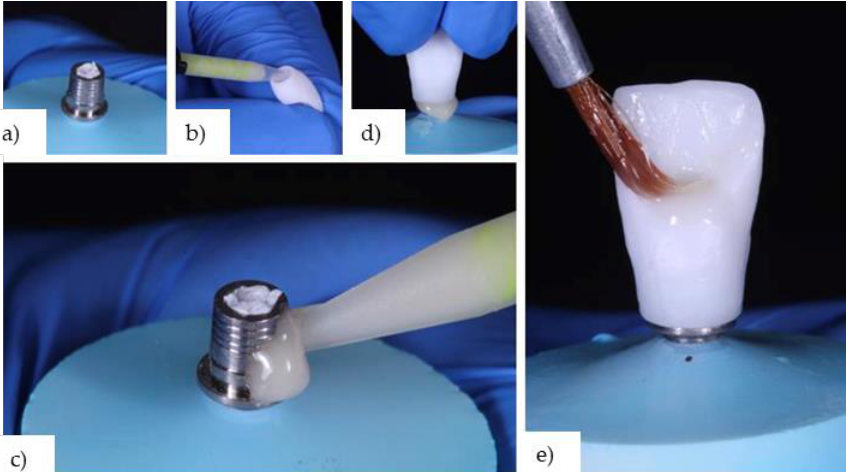
Figure 3. ( a ) Universal link abutment positioned and covered with Teflon tape; ( b ) application of the resin cement in the crown’s intaglio surface; ( c ) application of the cement on the metallic link surface; ( d ) seating the crown on the abutment with leakage of the cementing agent; ( e ) removal of excess cement.